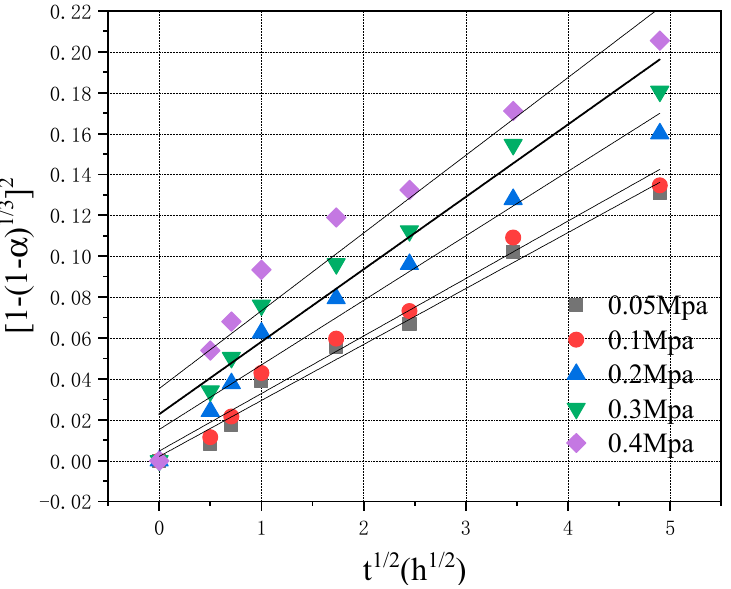
Figure 5. Test results and kinetic model of regression analysis.